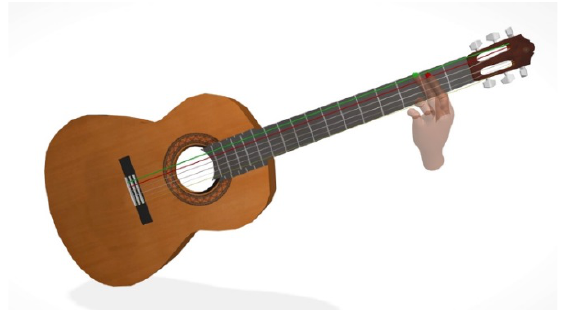
Figure 2. 3D model showing correct finger positions for the G chord.